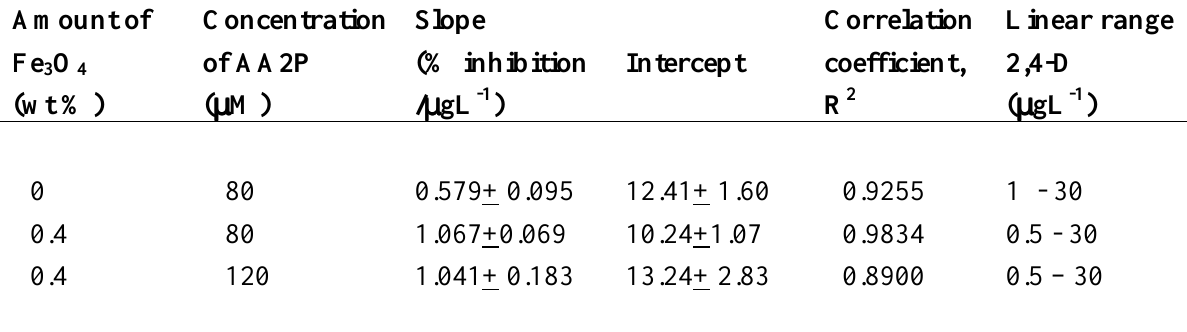
Table 2. The calibration curves of the biosensor with 0.4 wt% and 0 wt% immobilized Fe O nanoparticles in the presence of various concentrations of 2,4-D. The inhibition was 3 4 evaluated in the presence of two concentrations of AA2P substrate.